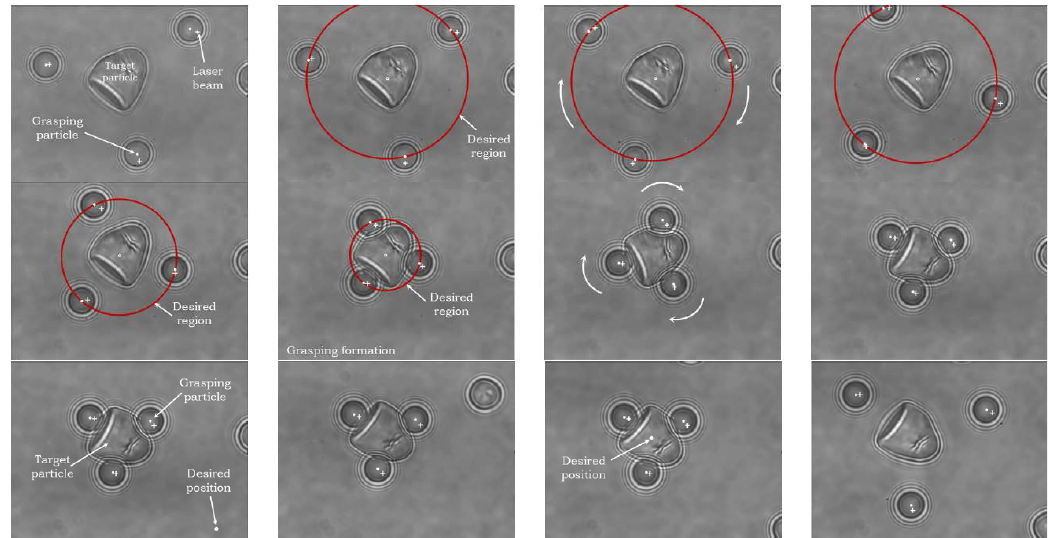
Figure 6. Snapshots of gripping and manipulation of a bell-like target particle. Reproduced with permission from [41].